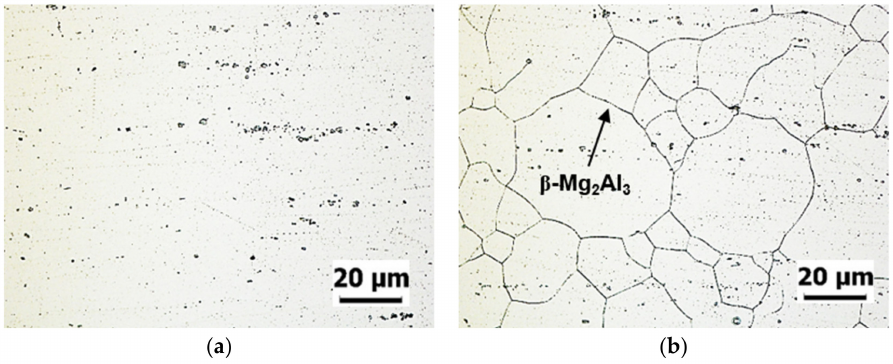
Figure 2. The microstructure of the extruded AlMg6 alloy with the specimen of ( a ) E and ( b ) ES etched by phosphoric acid etchant. The phase with black line in ( b ) represents the β -Mg 2 Al 3 precipitation.